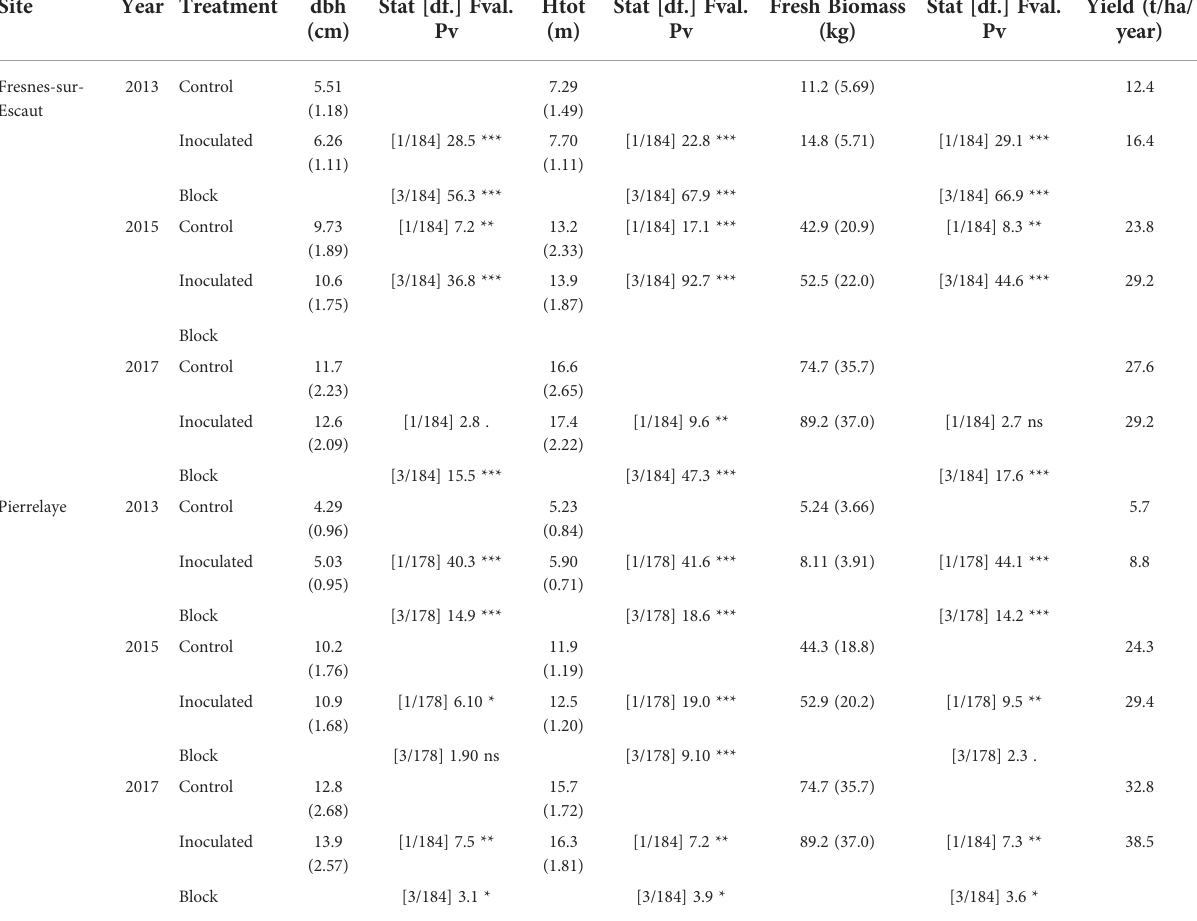
TABLE 2 Dendrometric parameters for poplars at the two experimental sites (Fresnes-sur-Escaut and Pierrelaye), inoculated or left uninoculated (control).